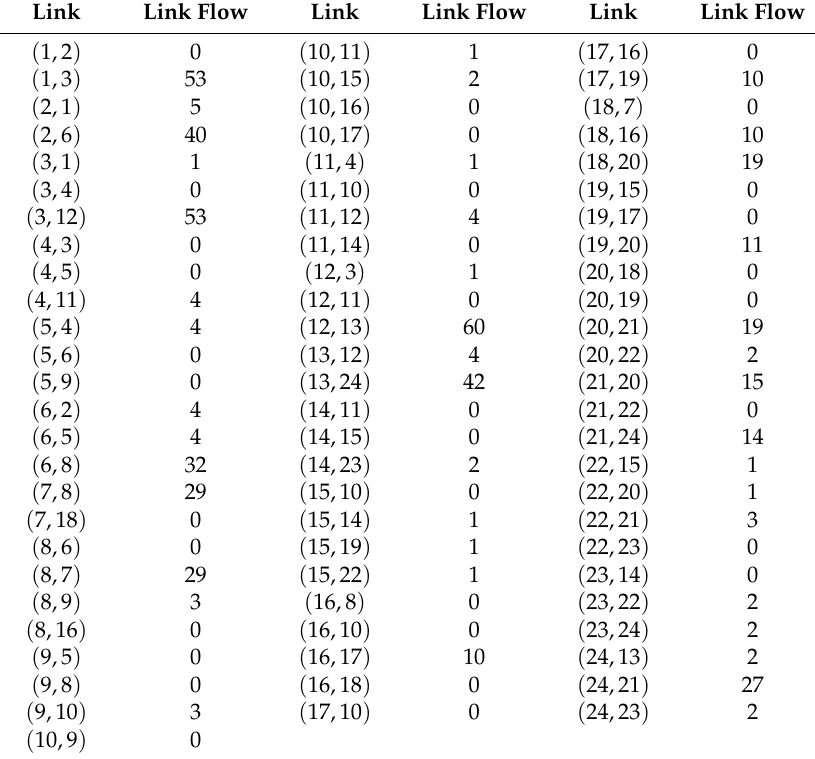
Table 17. Equilibrium link flow.